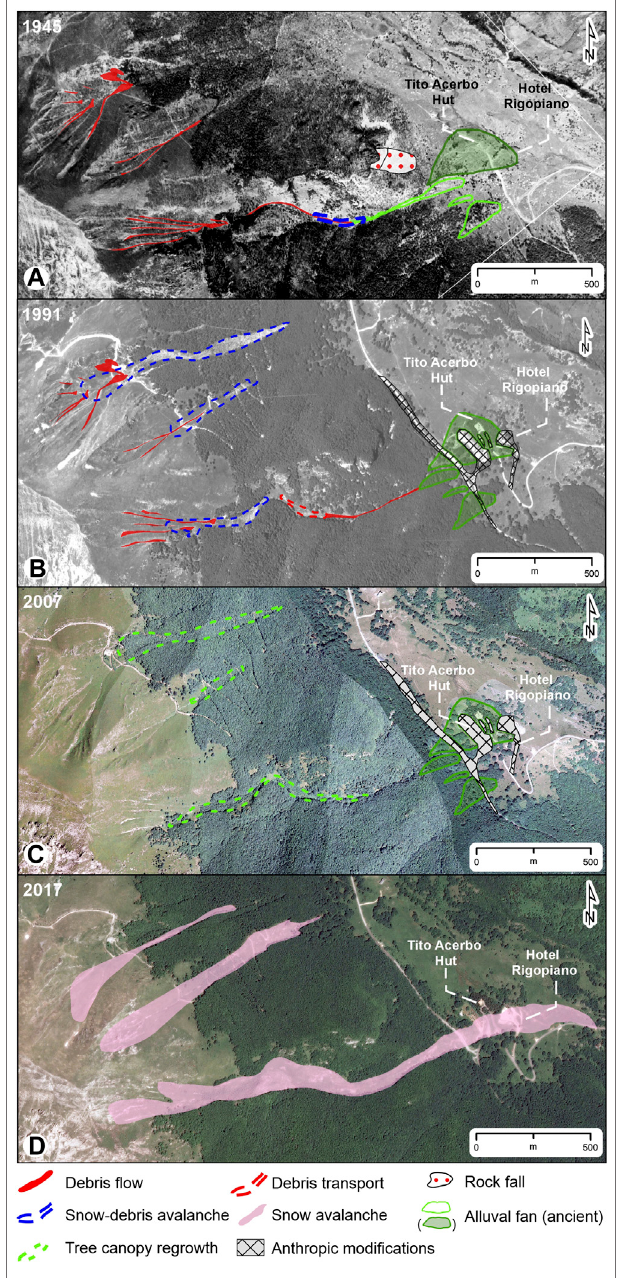
FIGURE 9 | Photogeological scheme of the Rigopiano area: (A) 1945, (B) 1991, (C) 2007, and (D) 2017.